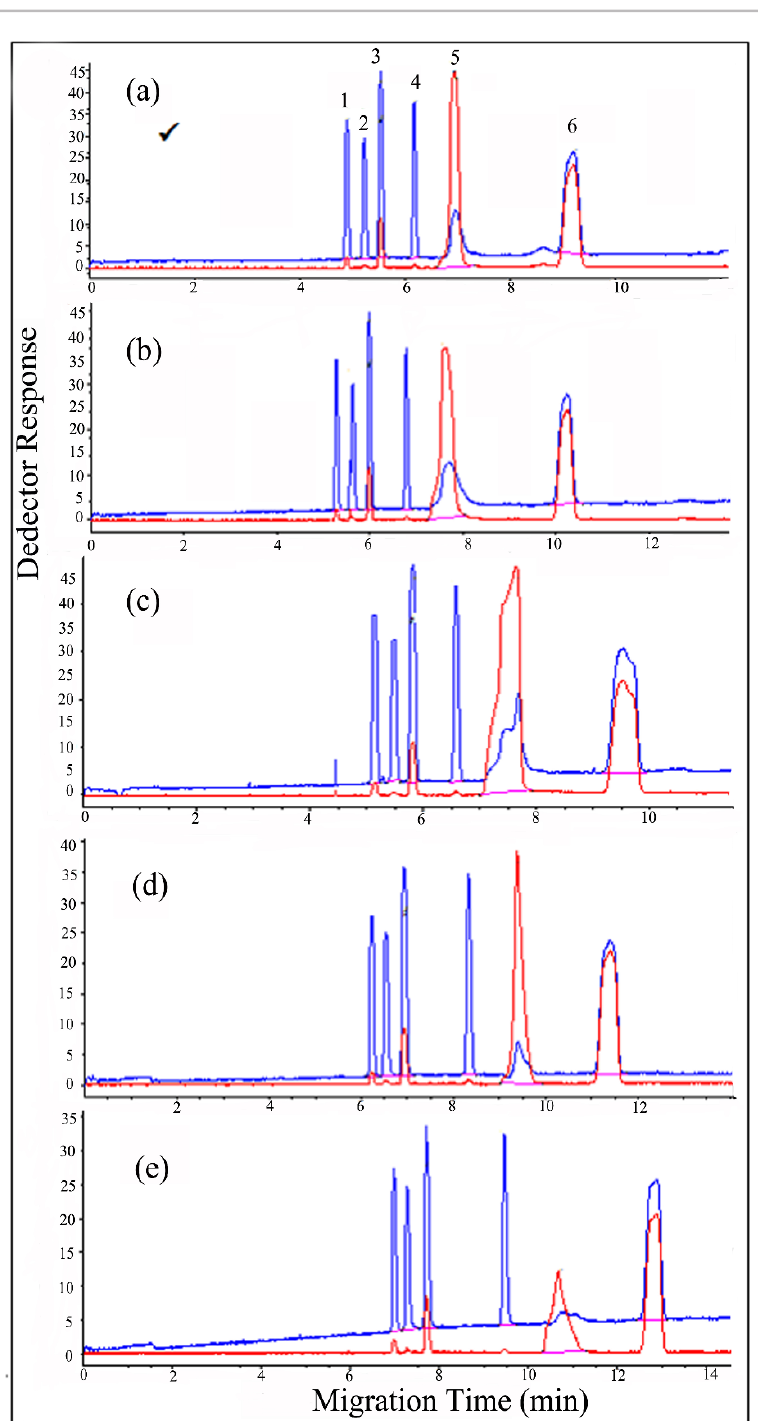
Figure S3 - Effect of temperature on analysis λ=214 nm (blue line), λ=257 nm (red line), Temperatures: a)30ºC b)25ºC c)20ºC d)15ºC e)10ºC, Conditions: Hydrodynamic injection Pinj=50 mbar, Isolation Voltage=30 kV, Capillary diameter: 75 μm, BGE: 75 mmol L-1 Sodium borate (pH: 8.0) buffer-15% ACN, Peaks: 1)DEX 2)EPH 3)CHL 4)PSE 5)4-AP